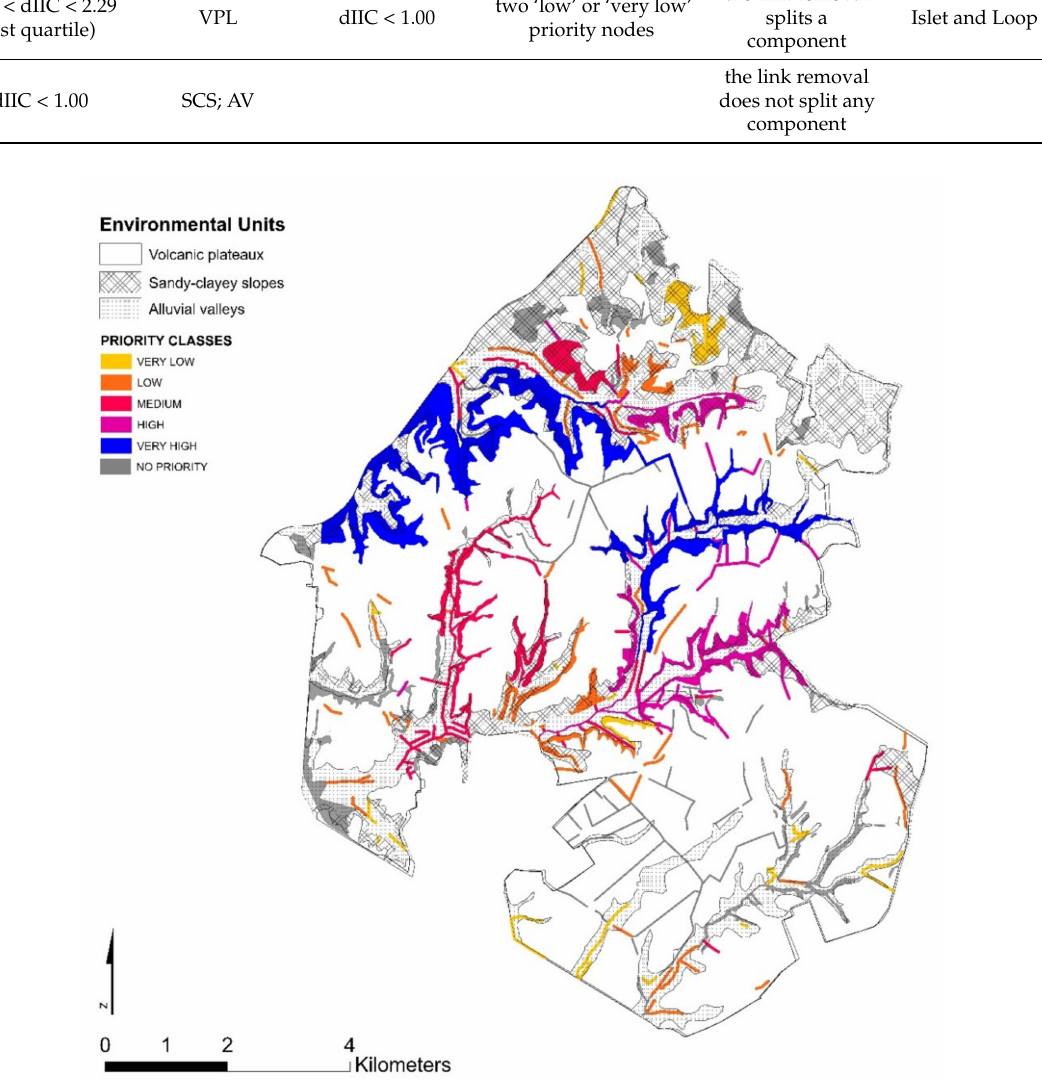
Figure 6. Distribution of comprehensive conservation priority of GI components in the Marcigliana Nature